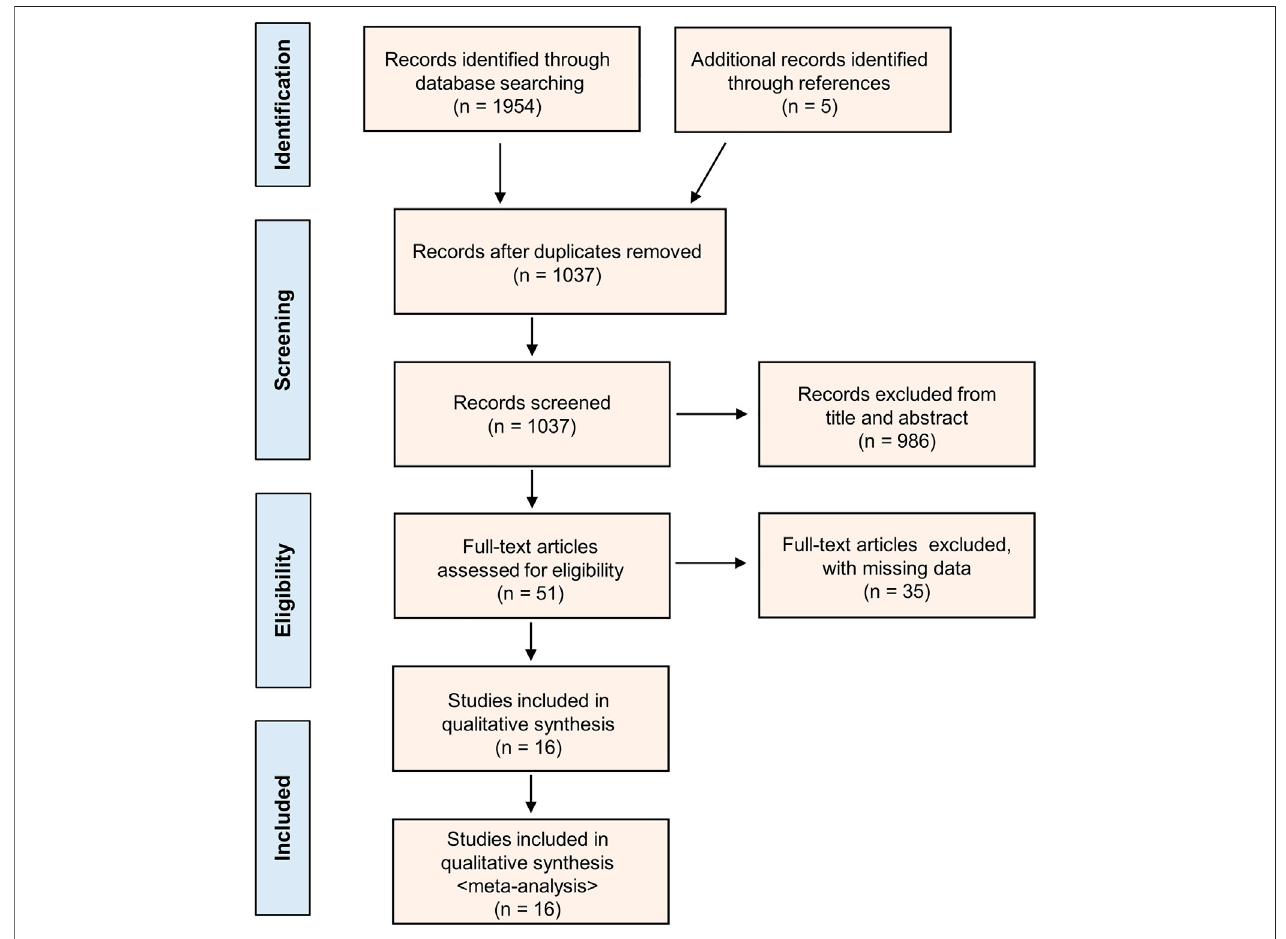
FIGURE 1 | PRISMA fl ow diagram showing the study